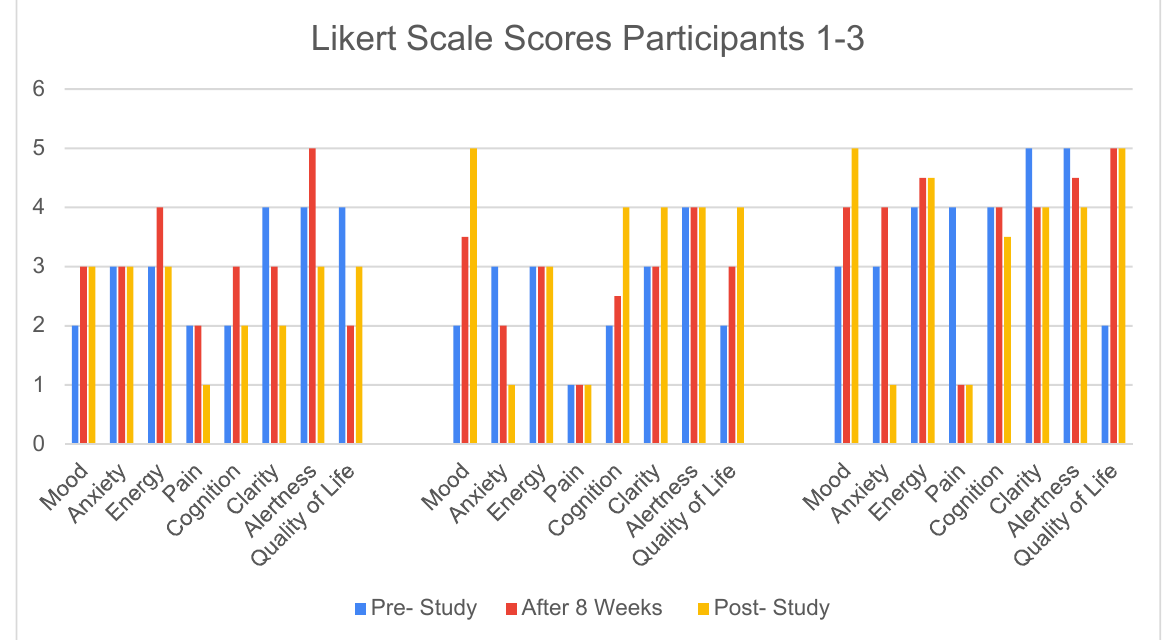
Figure 2. Participants’ Likert Scale Scores.